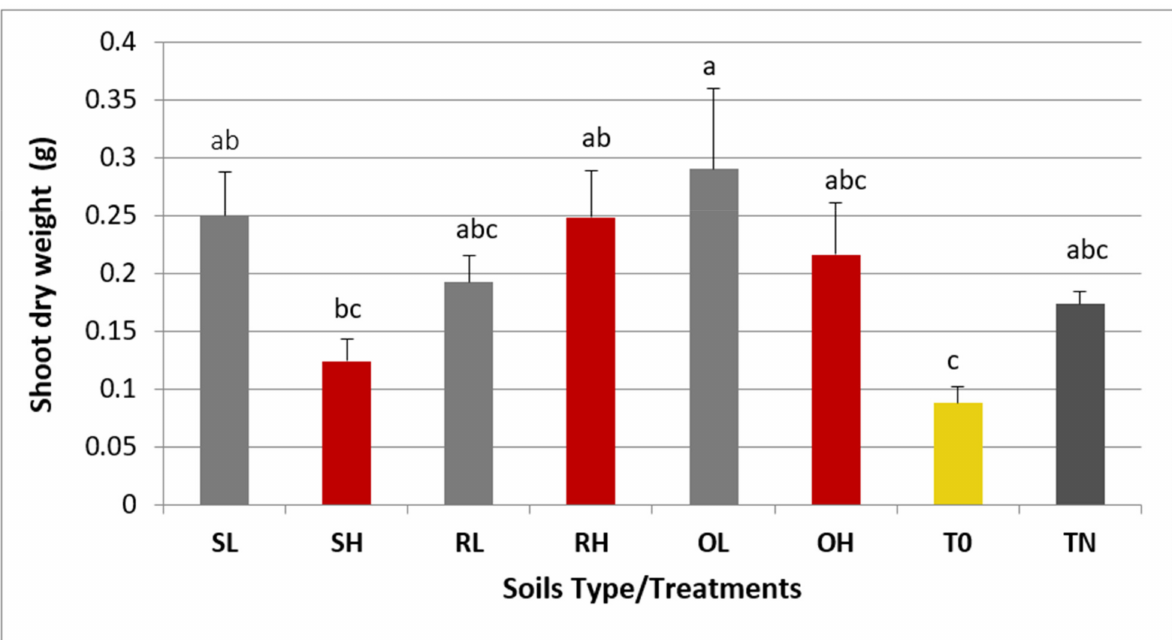
Figure 6. Dry weight of Vigna unguiculata plants inoculated with different soil samples. Population codes follow Figure 1. Uninoculated plants supplied either with nitrogen (TN) or without mineral N (T0) were also included. Values of shoot dry weight are the average ± SE of five replicates/soil type. Different letters (a, b, and c) above the columns express significant differences between treatments (including plants inoculated with the soil samples, TN, and T0) according to the Fisher’s LSD test at p ≤